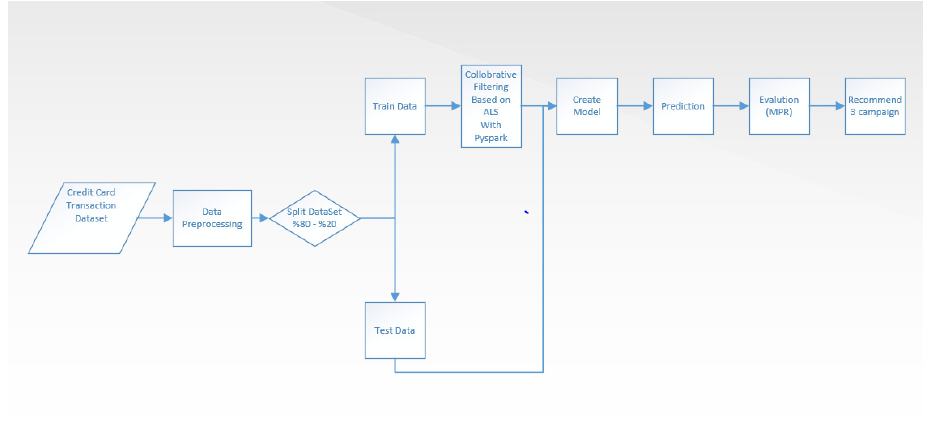
Figure 2. Architecture of the proposed